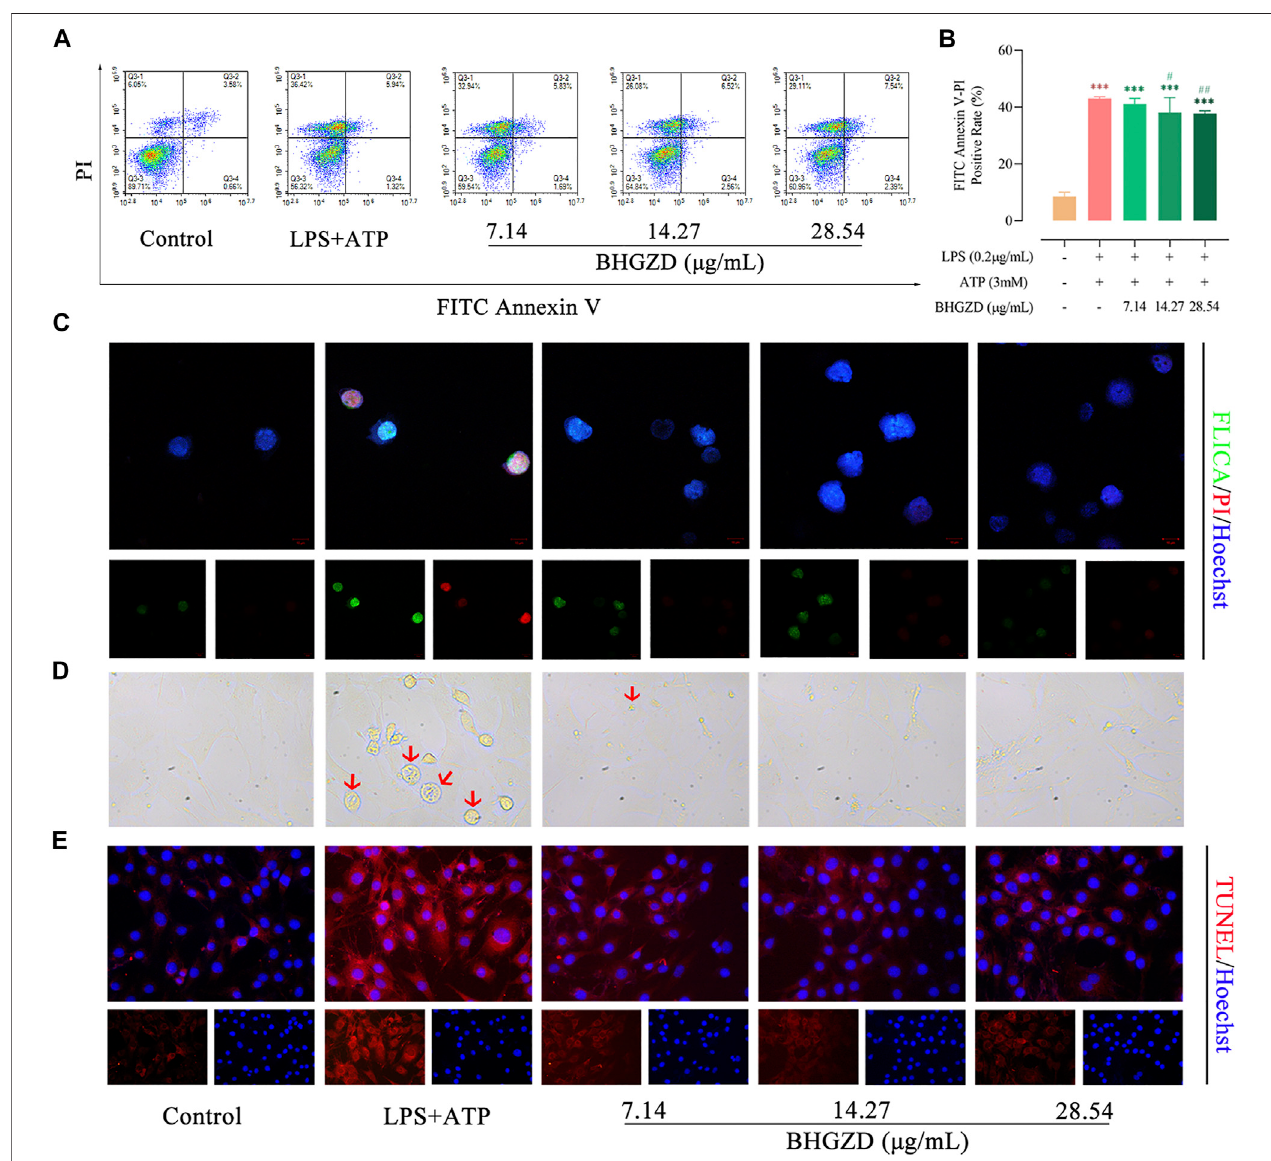
FIGURE 3 | BHGZD inhibits LPS/ATP – induced pyroptosis in both Raw264.7 macrophage and MH7A cells. (A ∼ B) Flow cytometry analysis for Annexin V/PI staininginRaw264.7macrophagecells. (C) RepresentativeimagesofFLICAcaspase-1thatbindsonlytoactivatedcaspase-1(scalebarrepresents10 μ m;FAM-FLICA green, PI red, Hoechst blue). (D) Representative phase-contrast images of MH7A cells (scale bar represents 50 μ m). Arrows indicate cells undergoing pyroptosis (swollen cells). (E) TUNEL staining of MH7A cells (scale bar represents 50 μ m; TUNEL red, Hoechst blue). ***, p < 0.001, in comparison with the normal control group; # and ##, p < 0.05 and p < 0.01, respectively, in comparison with the LPS/ATP – induced model.